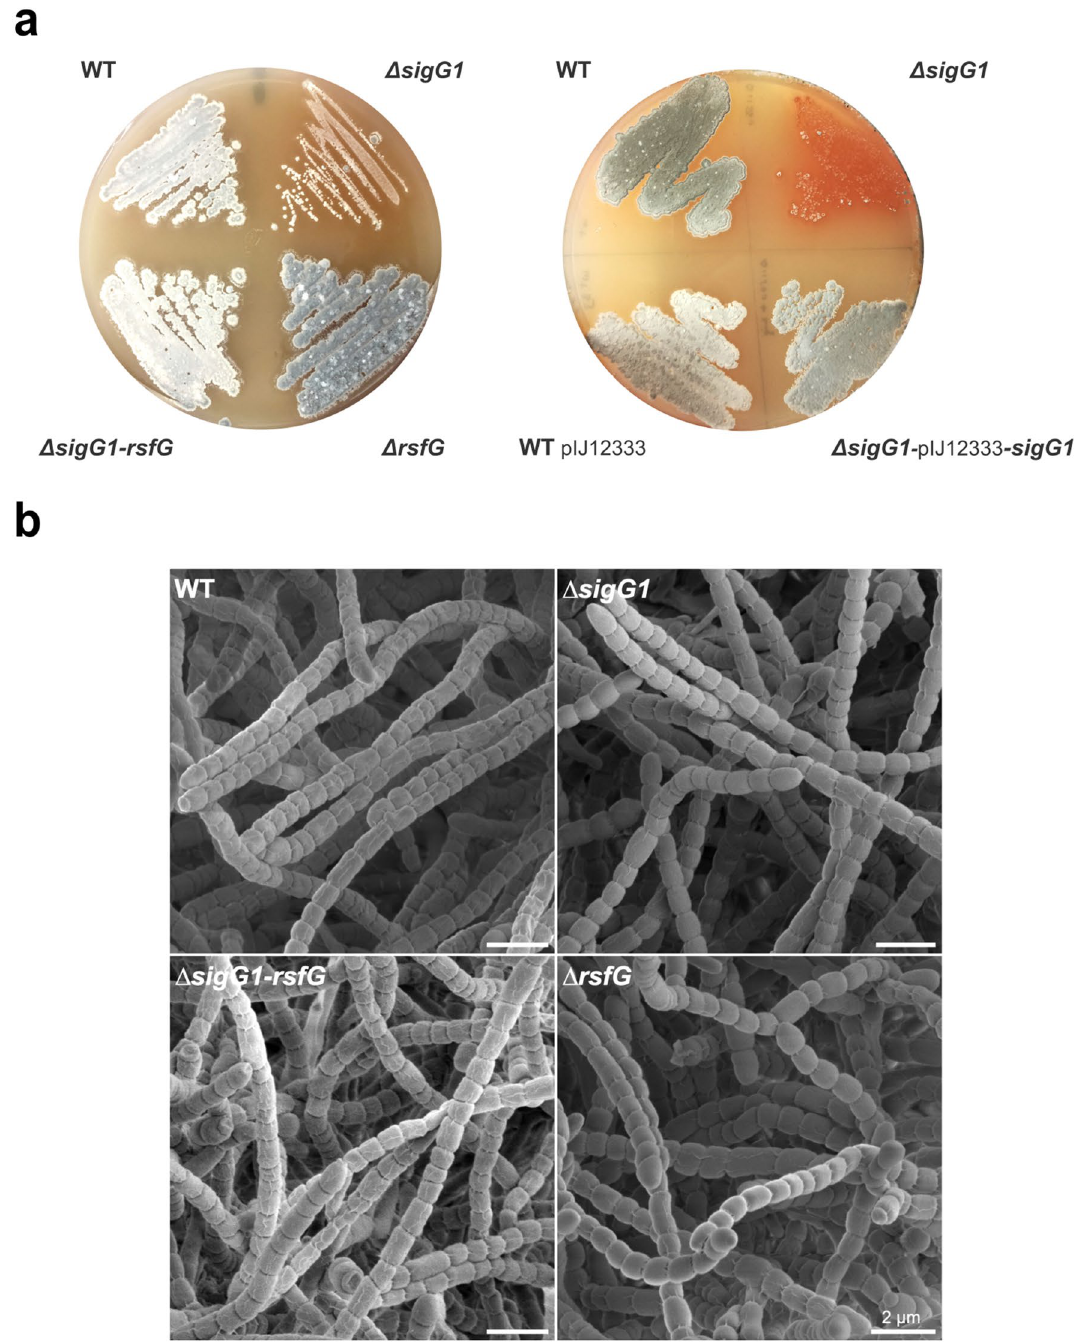
Figure 4. Phenotypes of the S. tsukubaensis wild-type, sigG1 and rsfG null mutants. ( a ) 10 6 spores were streak on ISP4 and grown for 14 days. To evaluate the phenotype of the complemented strains, 10 4 spores were plated on ISP4. The pIJ12333 vector was used to express sigG1 with its own promoter. The WT expressing the empty pIJ12333 is depicted as a control. ( b ) Differentiation into spores chains was examined by scanning electron microscopy (SEM), after 14 days of growth on ISP4. Scale bar: 2